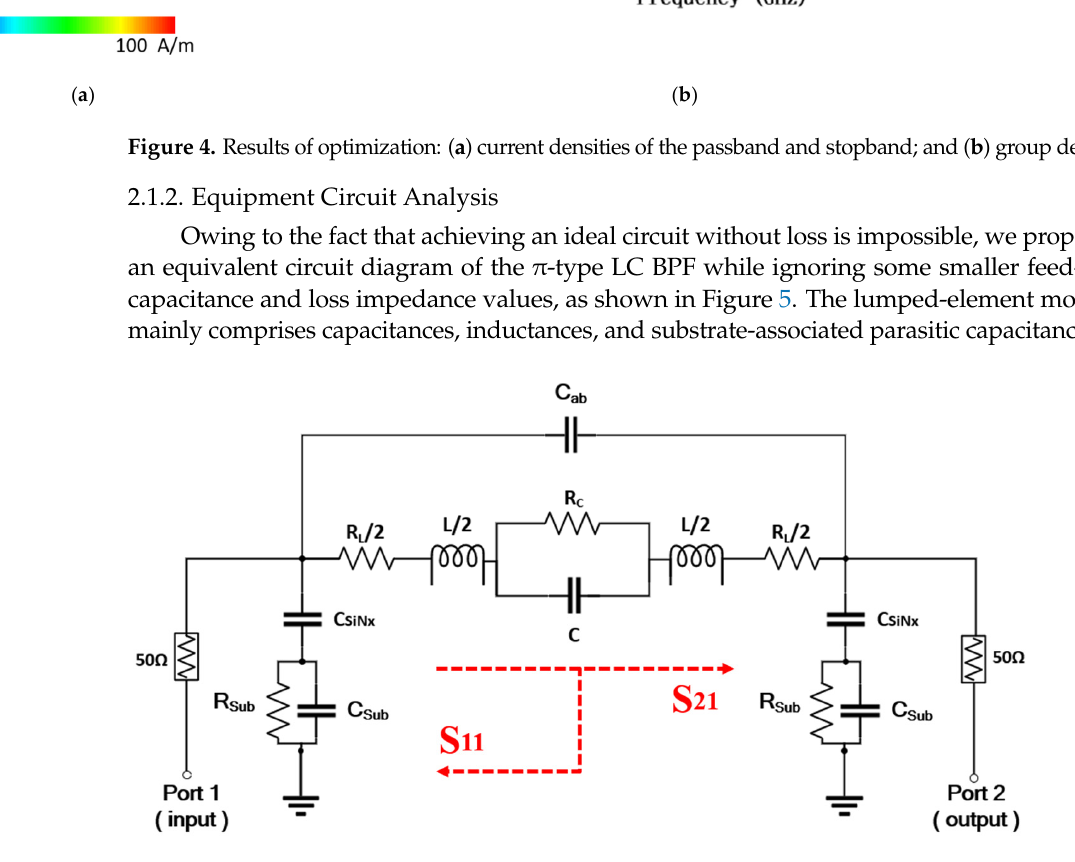
Figure 5. Equipment circuit model of the proposed